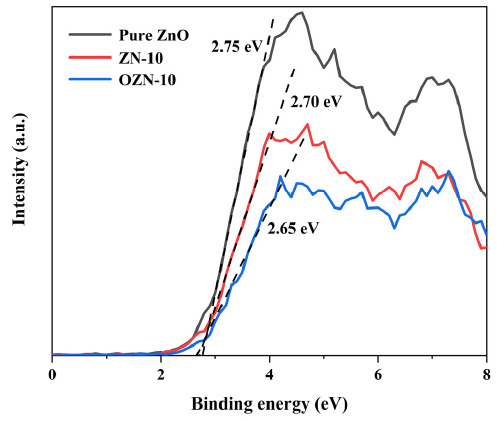
Figure 12. Valence band XPS spectra of pure ZnO, ZN-10 and OZN-10.